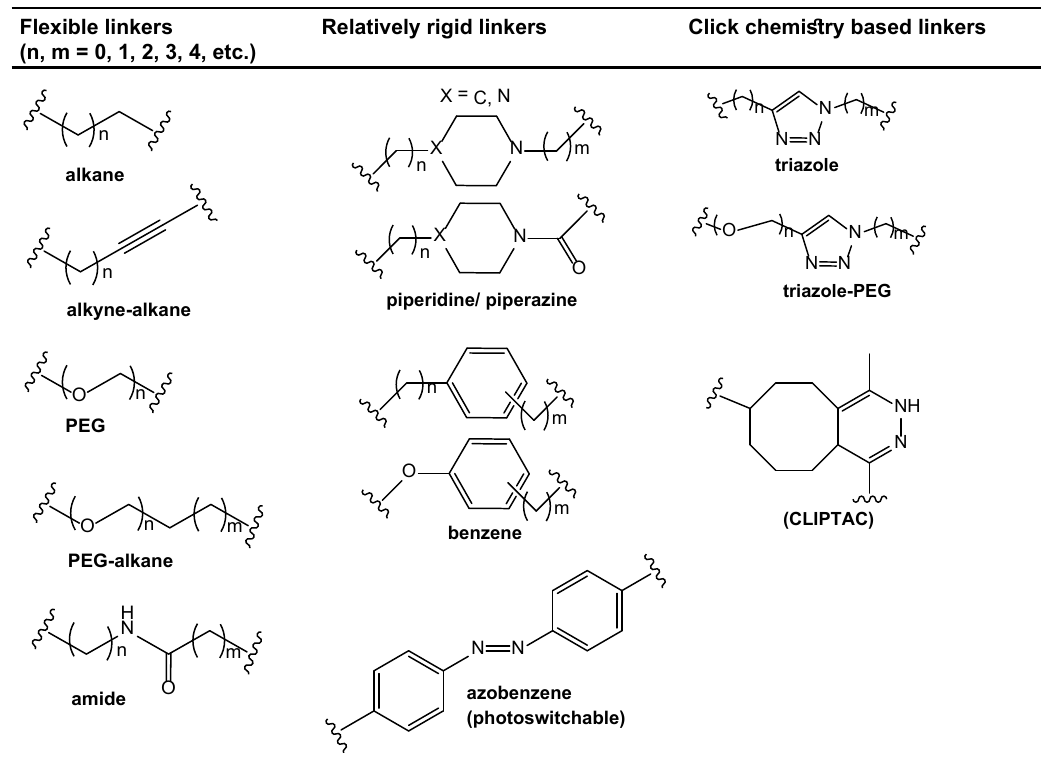
Explor Target Antitumor Ther. 2020;1:381-90 |